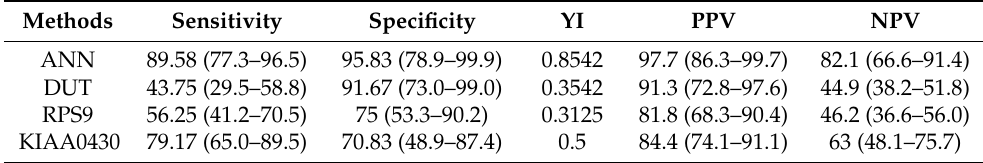
Table 1. Diagnostic efficacies of the prognostic model and single